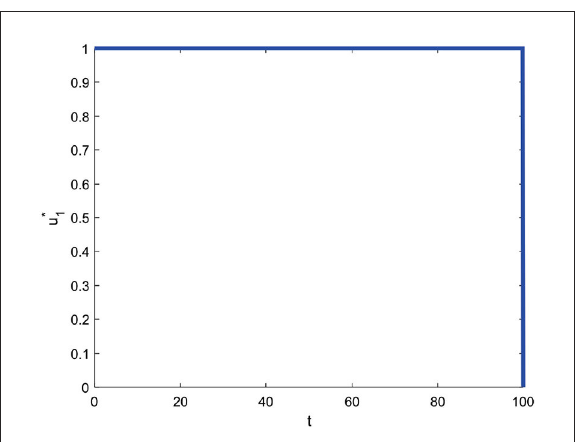
FIGURE8 The optimal control profile with u 1 6=